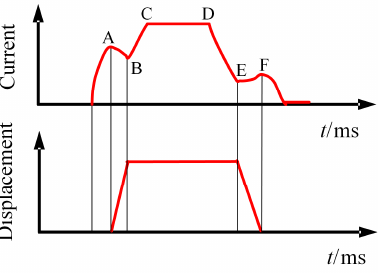
Figure 5. Current variation and spool displacement